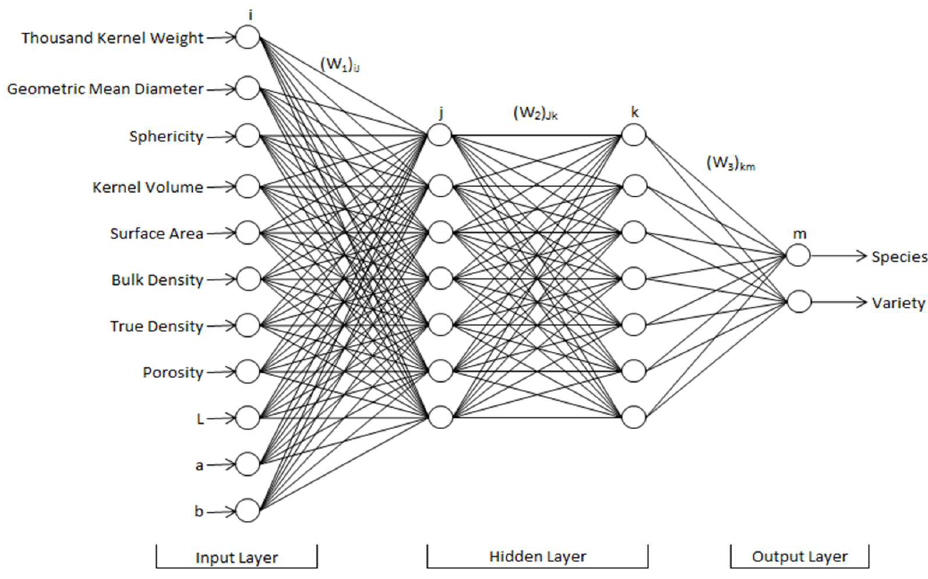
Figure 1. The Artificial Neural Network (ANN) structure.